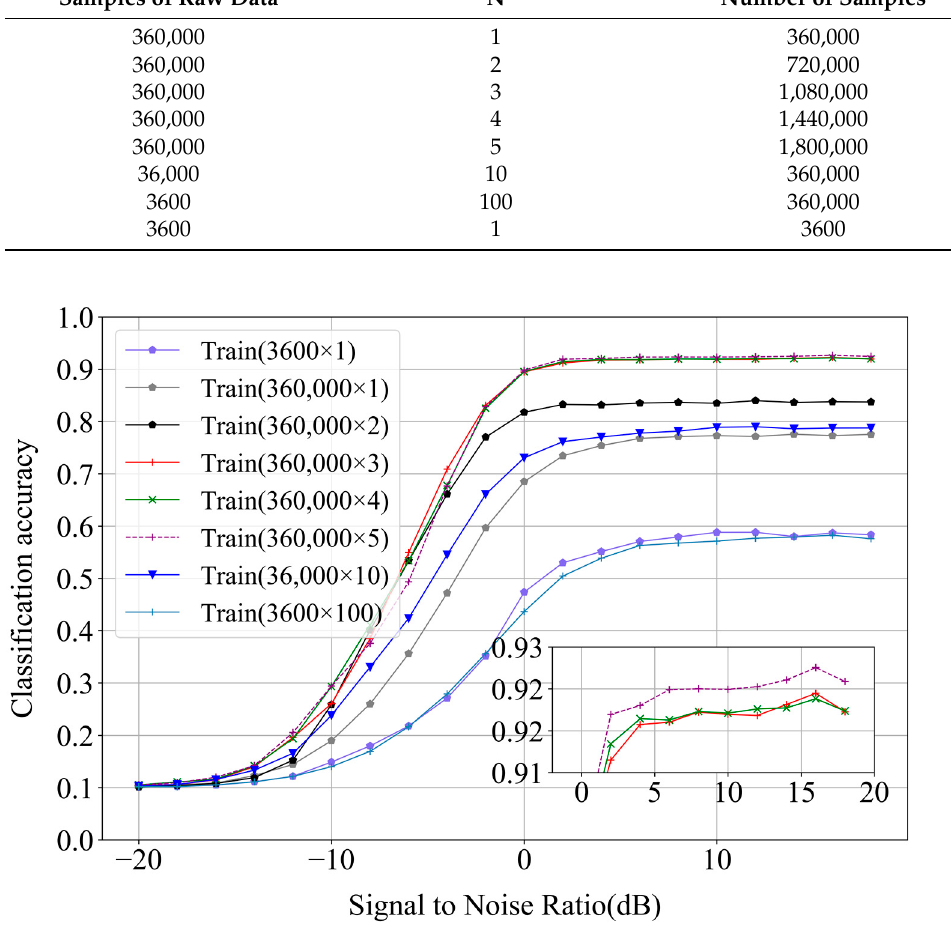
Figure 7. Effect of dataset size on recognition accuracy under different SNRs.